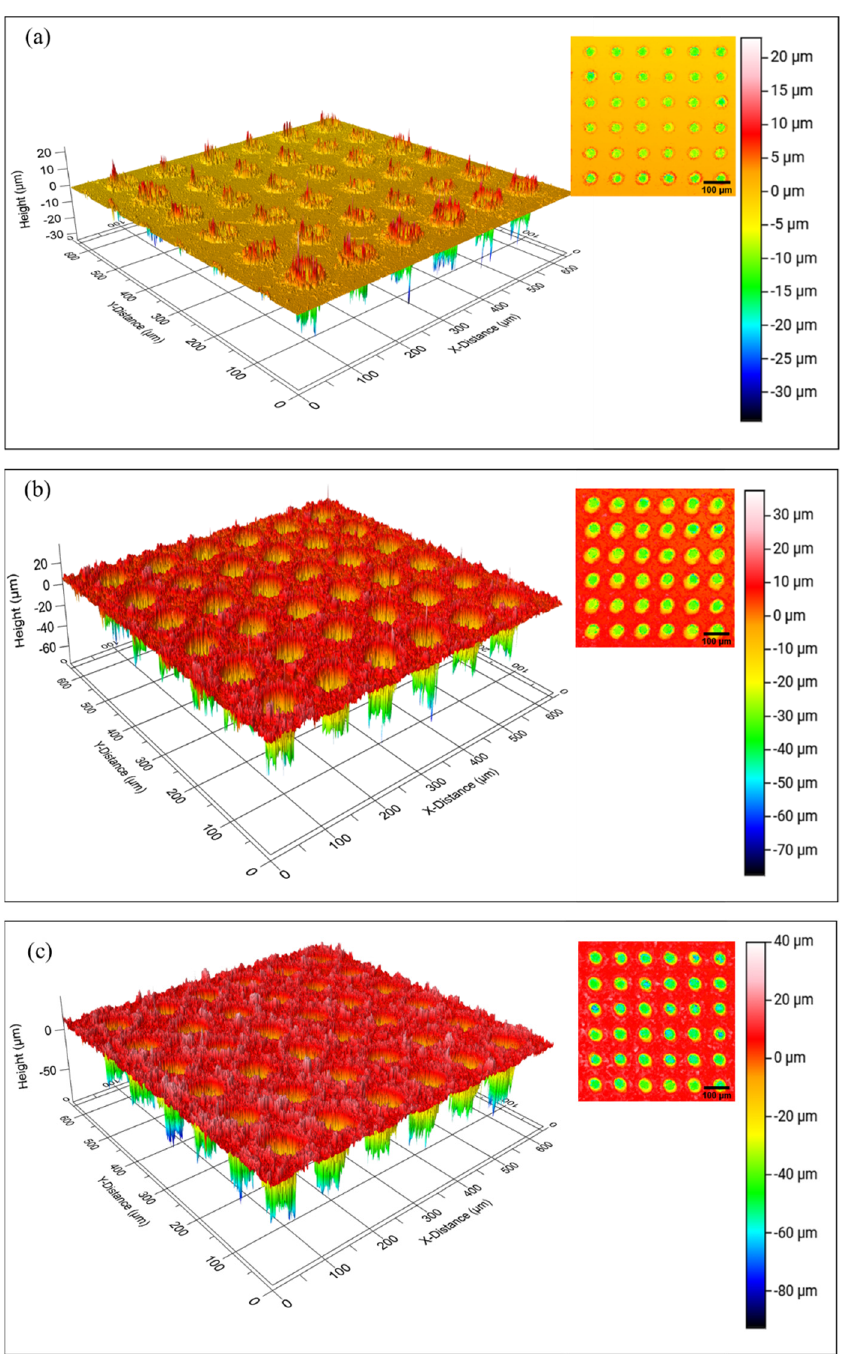
Figure 4. Images of the copper substrate with different depths of dimple, ( a ) 10 µm, ( b ) 30 µm, and ( c ) 50 µm. ( c ) 50 µ